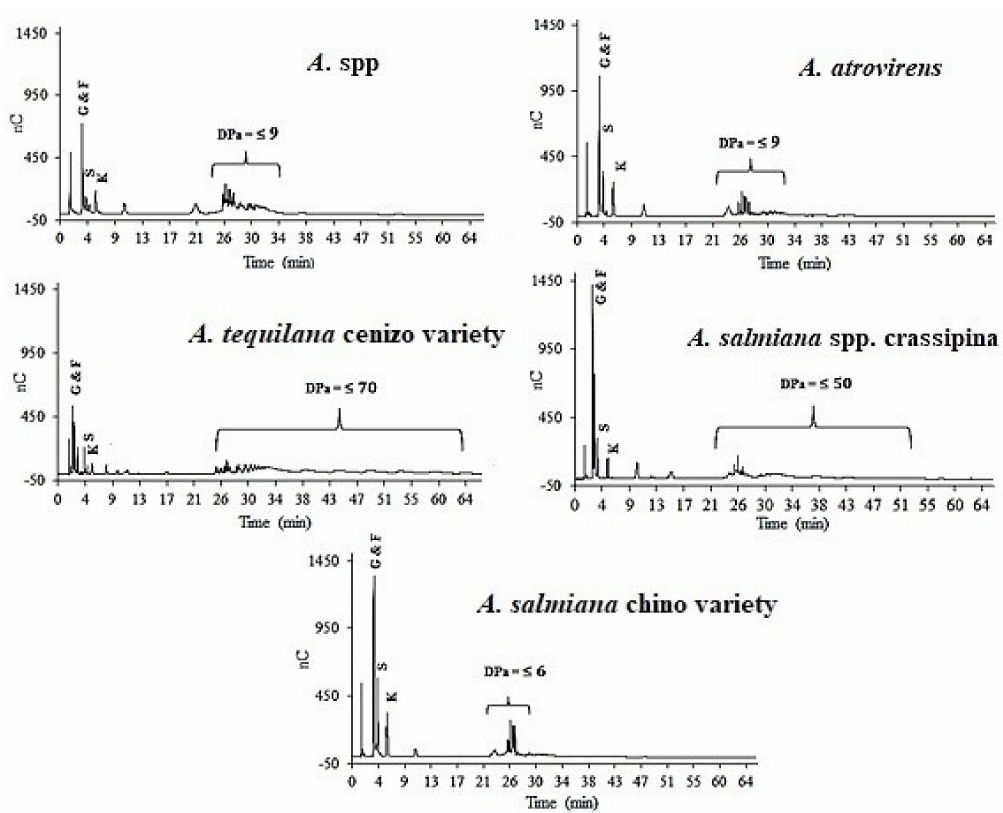
Figure 5. Fructan DP a dispersion of five wild agave varieties in adulthood (G, Glucose; F, Fructose; S, Sucrose; K, Kestose; N,